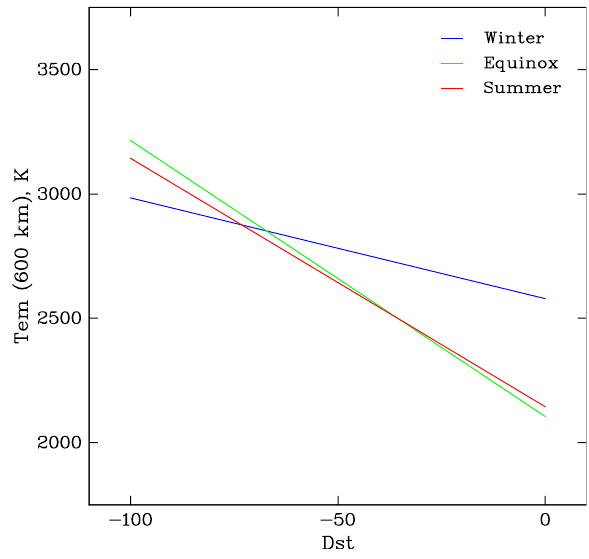
Fig. 10. Magnitude of the subauroral electron temperature enhance- ment as a function of geomagnetic activity. The format of data presentation is the same as in Fig. 9 except that the Dst index is replaced by the AE 6 index.